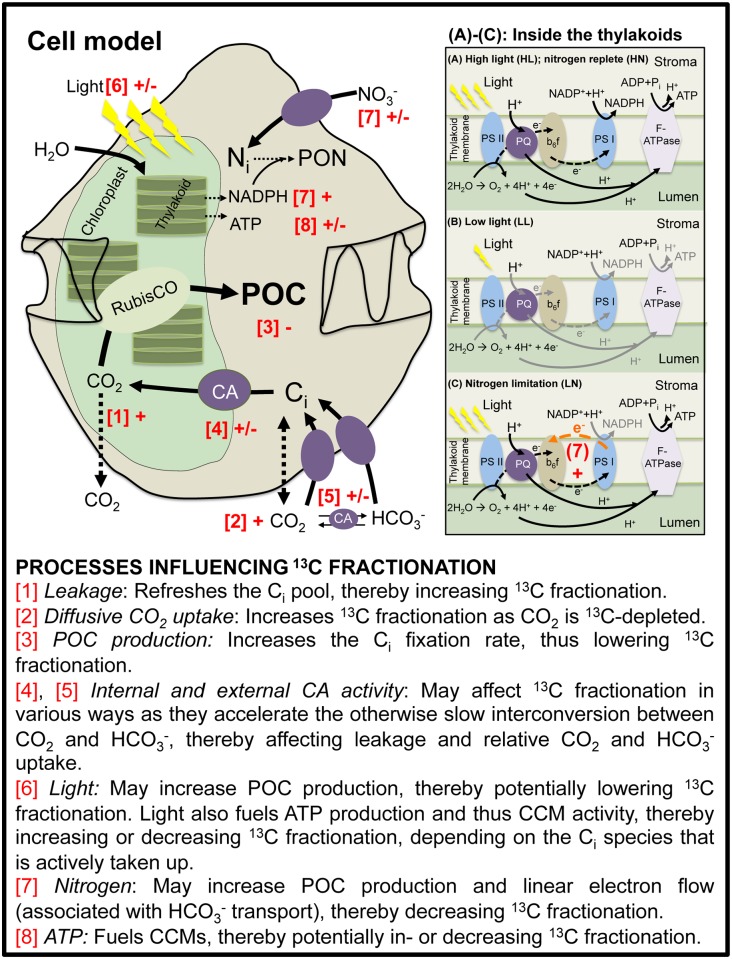
Conceptual model of a dinoflagellate cell and processes at the thylakoid membrane of the chloroplasts.(A) high-light (HL) and nitrogen-replete (HN) conditions, (B) low-light conditions (LL) and (C) nitrogen-limitation (LN). Processes potentially influencing 13C fractionation ([1]–[8]) are highlighted in red, while + and − refer to an increase or decrease in 13C fractionation, respectively. (A) Saturating light and nutrient-replete conditions: Light provides the energy (= photons) needed for Photosystem II (PSII; in thylakoid membrane) to oxidize water to O2, thereby producing electrons (e-) and protons (H+). Electrons are transported by plastohydroquinone (PQ), thereby pumping more protons into the lumen. The cytochrome b6f complex oxidizes PQ molecules, thereby producing electrons, which are then transported to Photosystem I (PSI) where they reduce NADP+ to NADPH. Protons are transported to F-ATPase to synthesize ATP. (B) Under light-limitation, the overall decreased amount of energy arriving at PSII causes a decrease in water oxidation, thereby producing less electrons and protons, and thus also less ATP and NADPH. (C) Under nitrogen-limitation, less NADPH is needed for NO3- reduction, thus the excess electrons are transported back to PSII by cyclic energy flow. Protons are still pumped by F-ATPase, thereby increasing the amount of ATP synthesized.